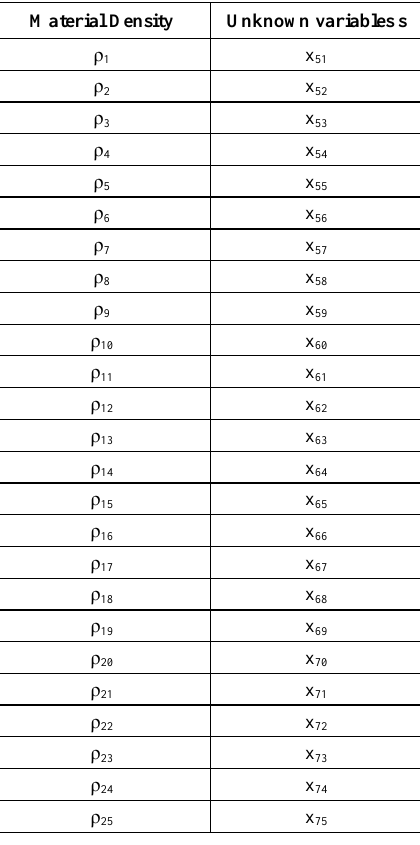
Table 7. Variables (x Material Density ρ Material